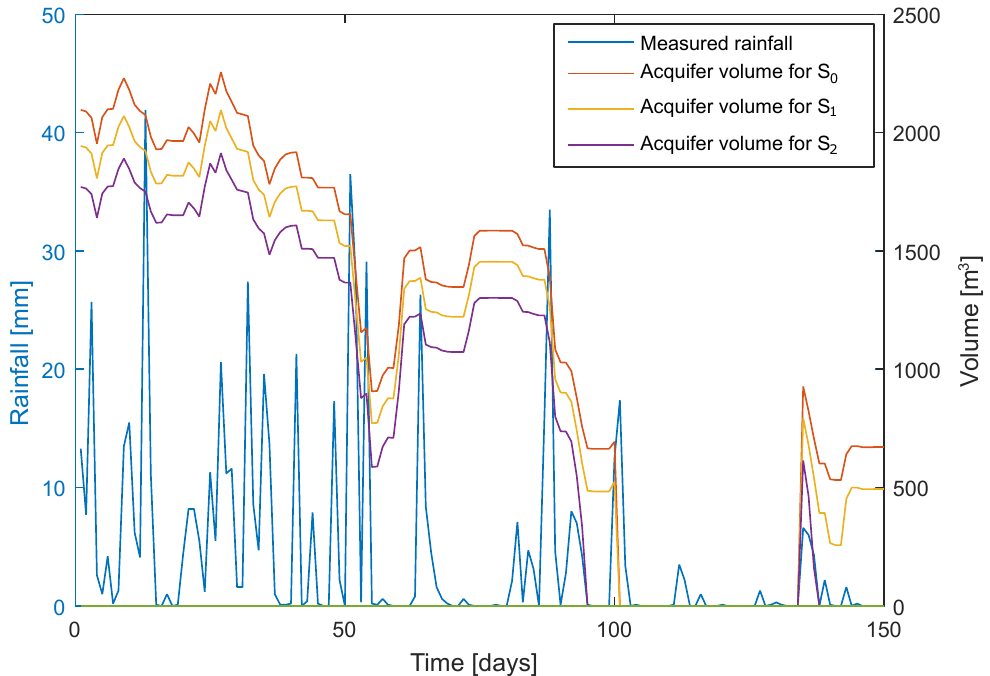
Figure 5. Aquifer recharge estimation (m 3 ) for three scenarios: baseline scenario S 0 and scenarios S 1 and S 2 , which consider 15% and 30% decreases in rainfall, respectively. Measured rainfall (mm) for S 0 is also